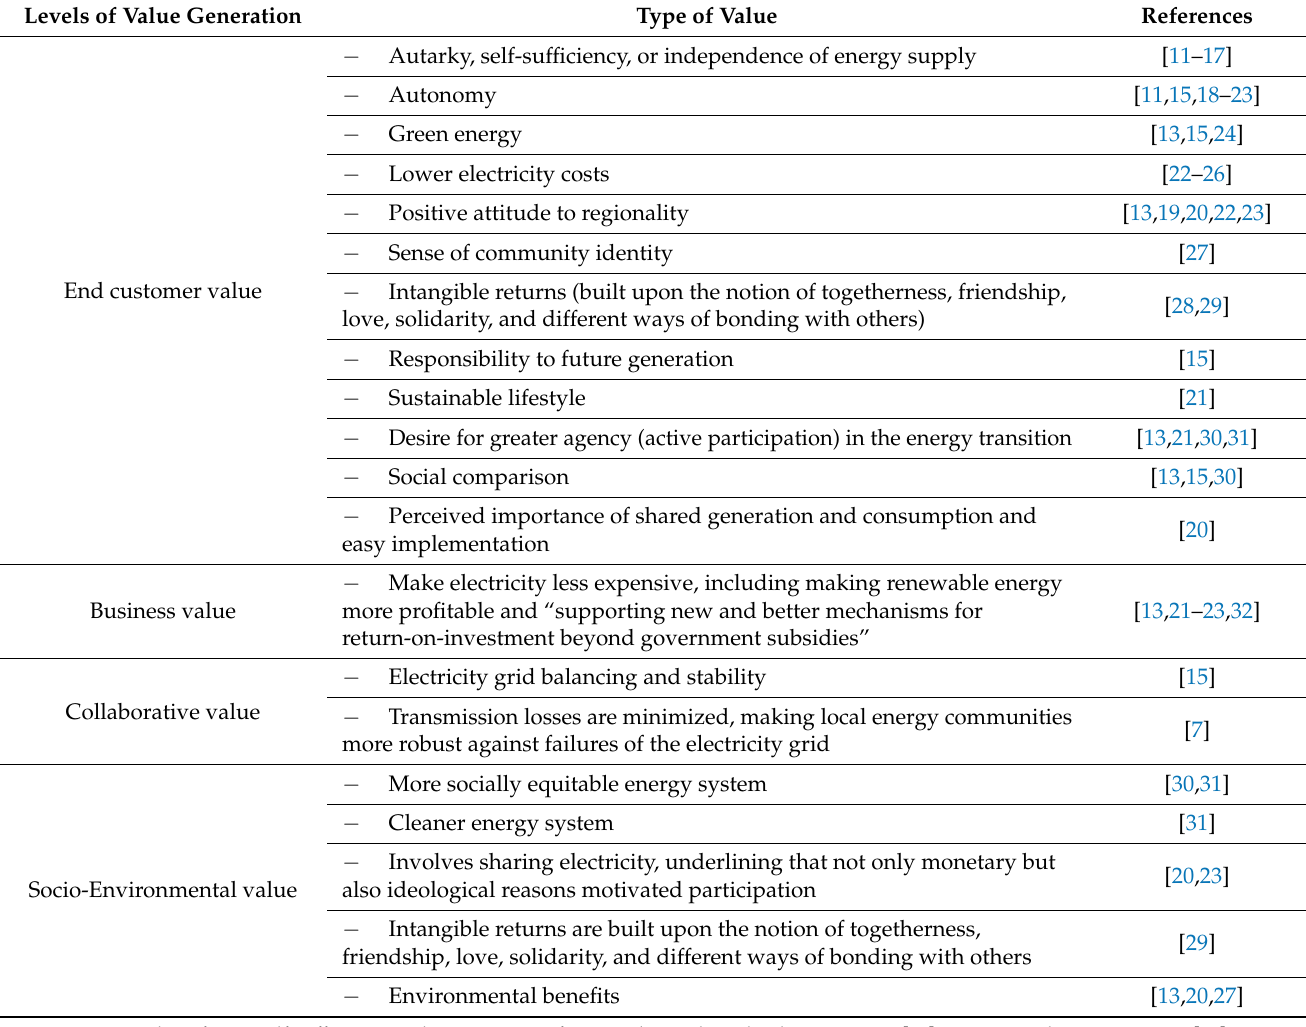
Table 1. Value proposition of peer-to-peer electricity trading at different levels reproduced from [6], Halmstad University Press: 2021. Levels of Value